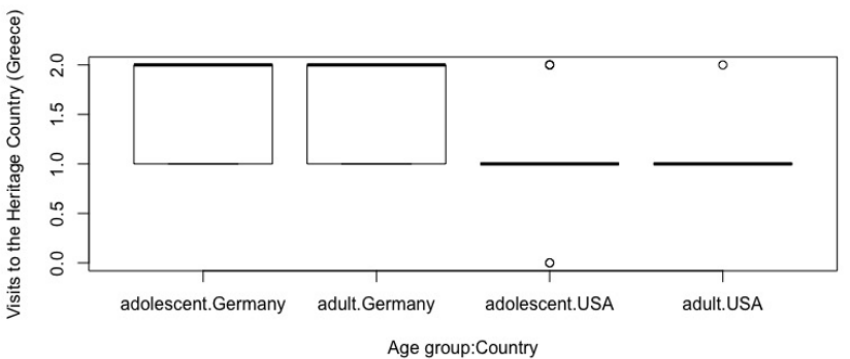
Figure 10. Visits to the Heritage country (Greece) for each heritage group (USA, Germany) and age group (adults, adolescents).